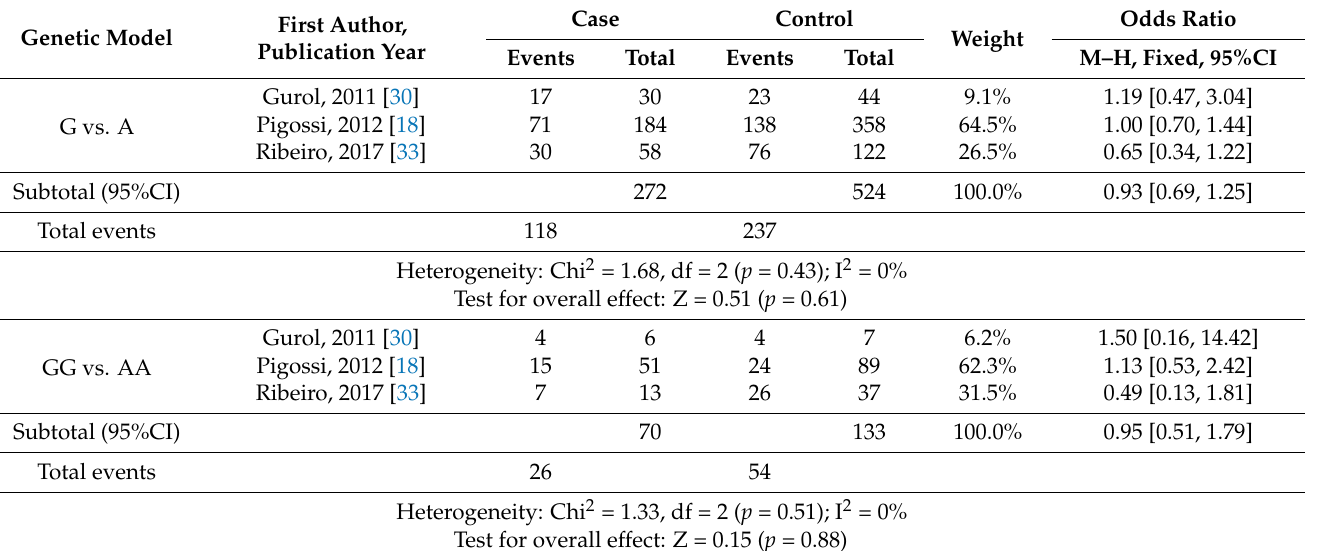
Test for overall effect: Z = 0.15 ( p =